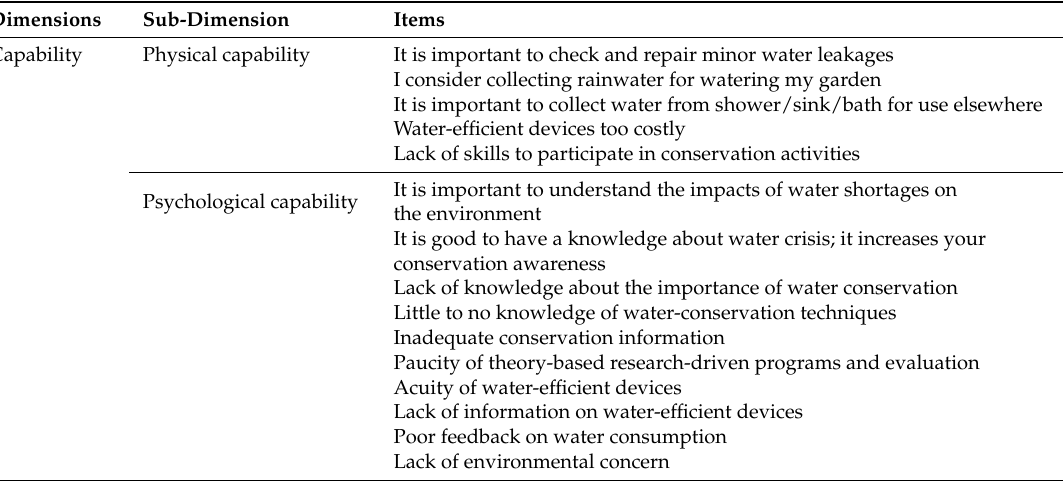
Table A1. Items used in Survey 1 assessing household water-conservation behavior attitudes, barriers and